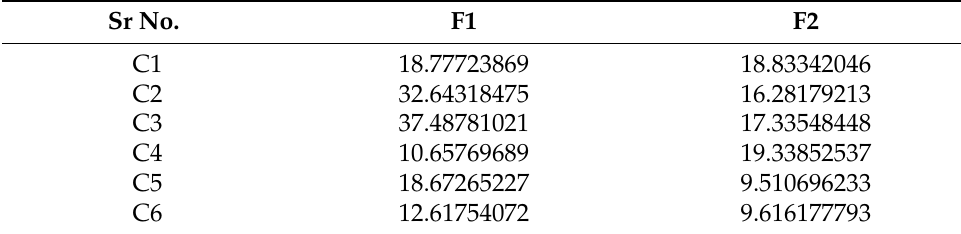
Table 15. The best centroids for Compound obtained by proposed approach. Sr No.